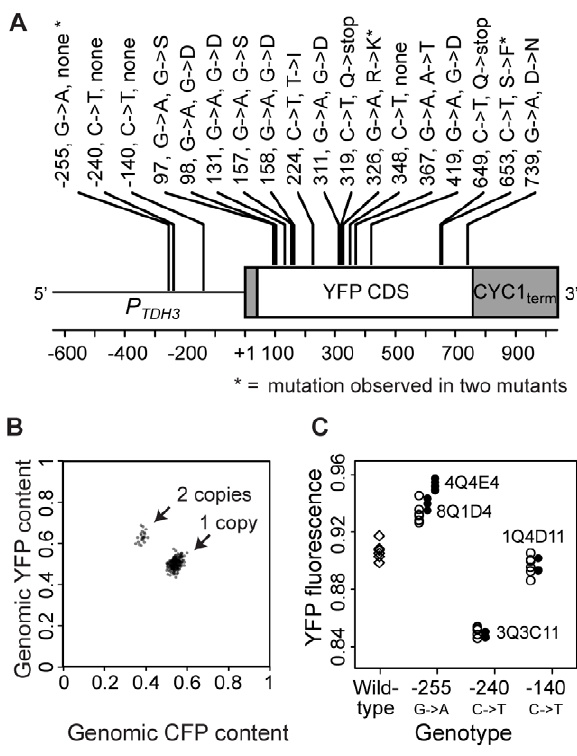
Figure 2. Mutations in the coding and promoter sequences of P TDH3 -YFP as well as changes in its copy number were found among the 231 mutant genotypes. (A) The schematic depicts the P TDH3 -YFP reporter gene and is drawn to scale. Annotations indicate the location of each mutation relative to the transcription start site ( + 1) of TDH3 [68], the nucleotide substitution observed, and the change in amino acid sequence if applicable. Asterisks indicate mutations observed in two mutant genotypes. Mutations at positions 2 255, 2 240 and 2 140 are located within the promoter, and the mutation at position 348 is a synonymous change. (B) In 221 of the 231 mutants, the relative copy number of P TDH3 -YFP and P TDH3 -CFP was determined by pyrosequencing. Clusters of points representing genotypes with one copy of P TDH3 -YFP (CFP and YFP < 1/2) and two copies of P TDH3 -YFP (CFP < 1/3 and YFP < 2/3) are indicated with arrows. (C) Median YFP fluorescence is plotted for each of the replicate populations analyzed for eight distinct genotypes: unmutagenized cells containing the ‘‘wildtype’’ P TDH3 -YFP sequence (diamonds); each of the four regulatory mutant genotypes (8Q1D4, 4Q4E4, 3Q3C11, and 1Q4D11 in Table S3) that contained a promoter mutation (filled circles); and genotypes in which one of the promoter mutations ( 2 255, 2 240, or 2 140) was introduced into same genetic background as the wildtype P TDH3 -YFP gene (open circles). Populations of cells containing any one of the promoter mutations showed a significant change in YFP fluorescence relative to the wildtype genotype ( P 2 255 = 0.002, P 2 240 = 0.002, P 2 140 =0.015, MWW test). The mutation at 2 255 had an effect on YFP fluorescence equivalent to that of mutant genotype 8Q1D4 ( P =0.261, MWW), but not to that of mutant genotype 4Q4E4 ( P =0.0002, MWW). The effects on YFP fluorescence of mutations